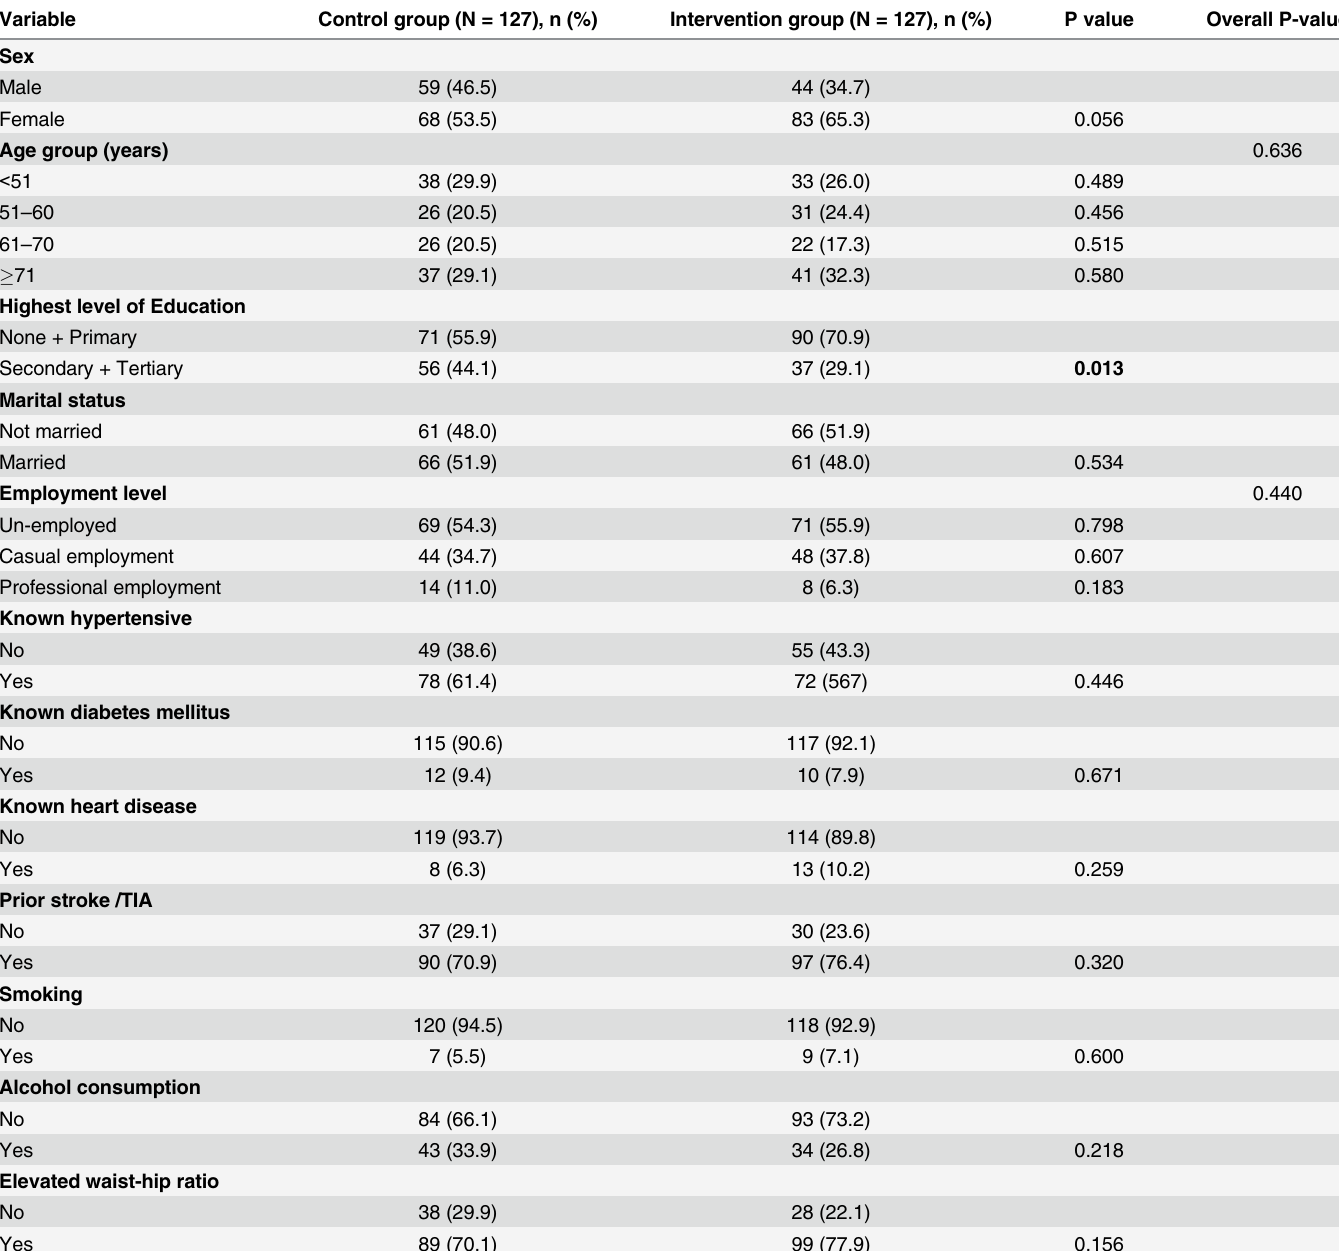
Table 2. Social demographic characteristics of the study